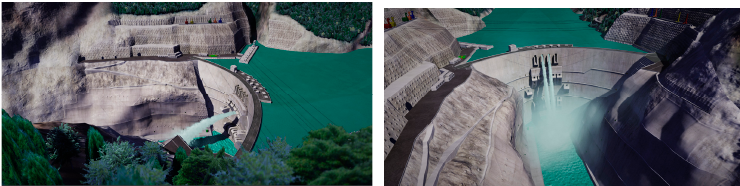
4). The normal storage level of the reservoir is 1880.0 m, dead water level is 1800.0 m, and